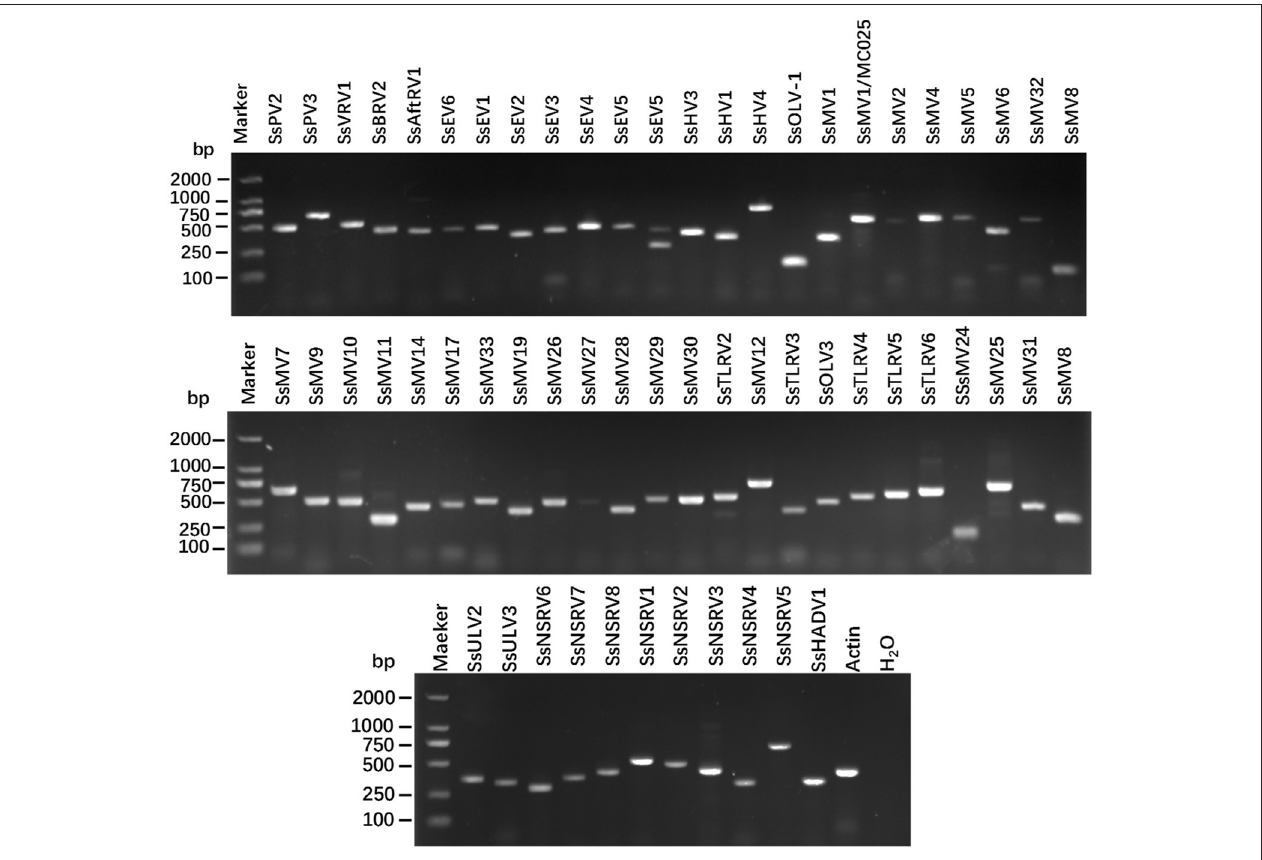
FIGURE 1 | RT-PCR confirmation of mycovirus contigs. RT-PCR confirmation of de novo assembled mycovirus contigs from Sclerotinia sclerotiorum generated by Illumina sequencing. The presences of viral sequences identified by BLAST analysis were confirmed by RT-PCR products generated from total RNA samples. The primers were designed according to the contigs’ sequences (genomic sequences of putative mycoviruses). Primers pairs used and predicted sizes of amplicons are listed in Table S3. Lane M, DNA marker, 2,000 bp DNA Ladder (Takara Bio Inc., Japan); Lane 1 to 58, abbreviates of viruses (see Table 1 for detail), Lane H 2 O, ddH 2 O was instead of RT products as control.